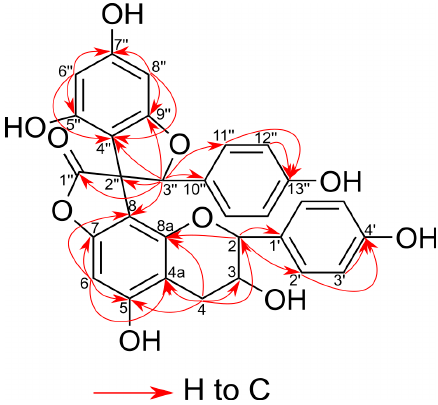
Figure 3. Key heteronuclear multiple bond coherence (HMBC) correlations for compounds 15 , 26, and 29 .